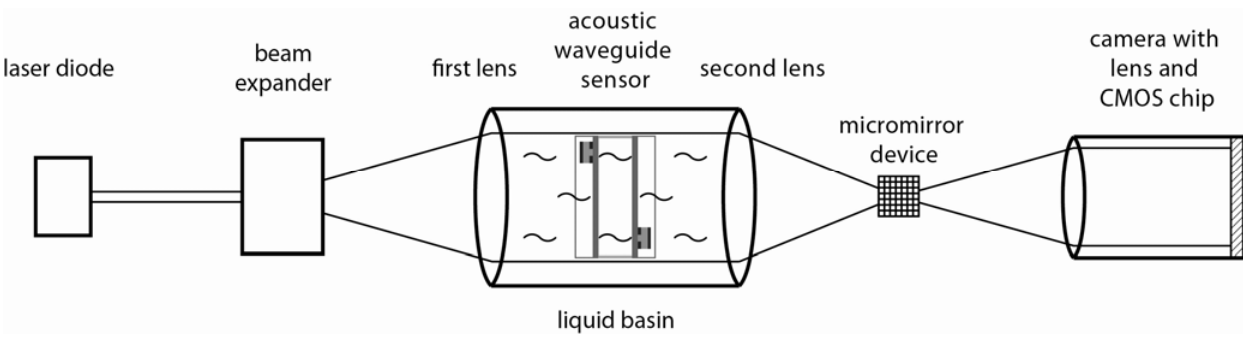
Figure 6. Measurement setup for the Schlieren system.